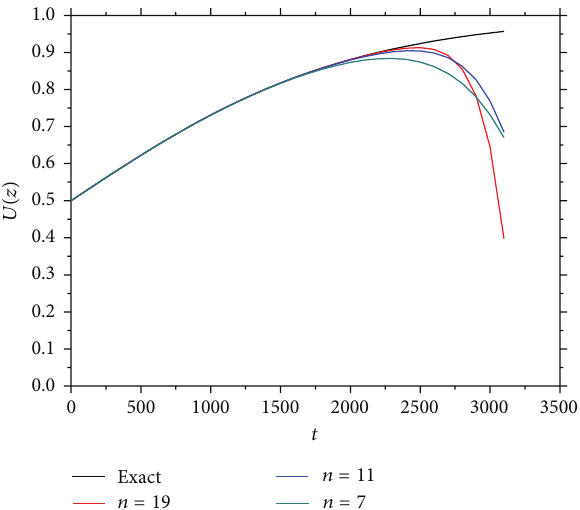
Figure 8: Trajectories of the approximate solution of generalized Burgers-Fisher-type equation, (24), with 𝛿 = 1 , 𝛾 = 0.01 , and ] = 0.01 , for 𝑥 = 0.9 .